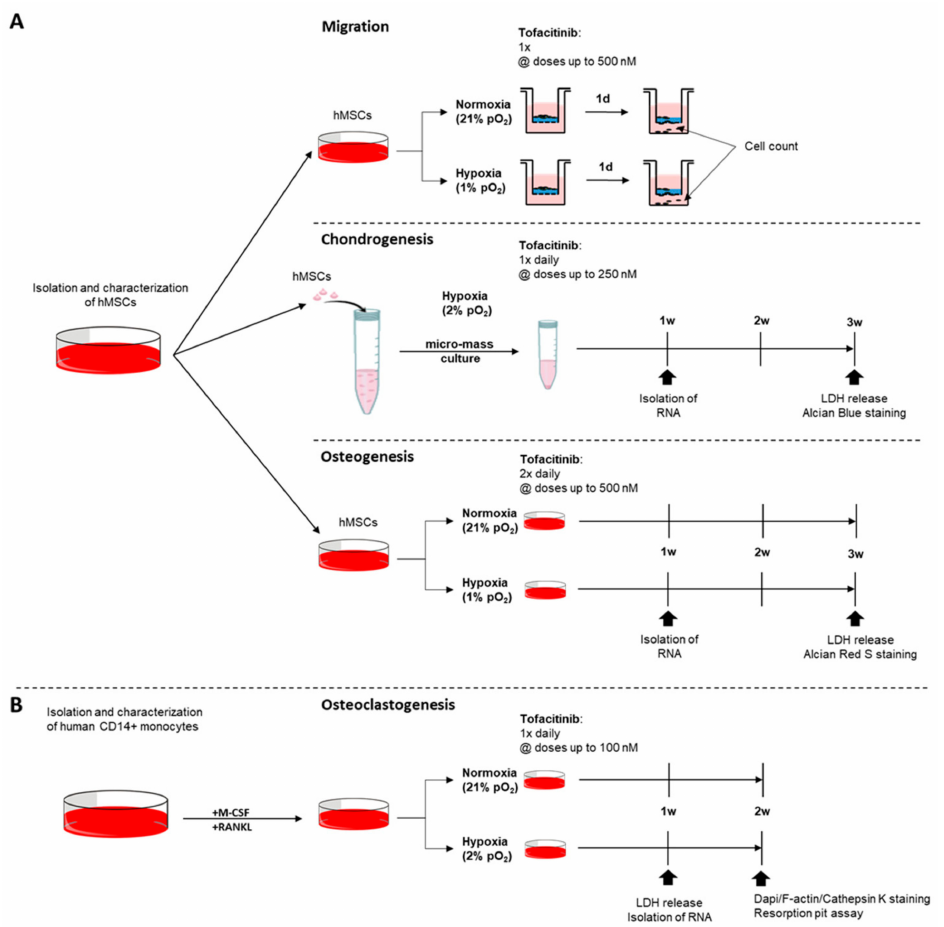
Figure 6. Experimental design. Assays on the impact of tofacitinib on ( A ) hMSCs with focus on (i) migration, (ii) chondrogenic di ff erentiation, and (iii) osteogenic di ff erentiation and ( B ) monocyte to osteoclast di ff erentiation taking into account the availability of